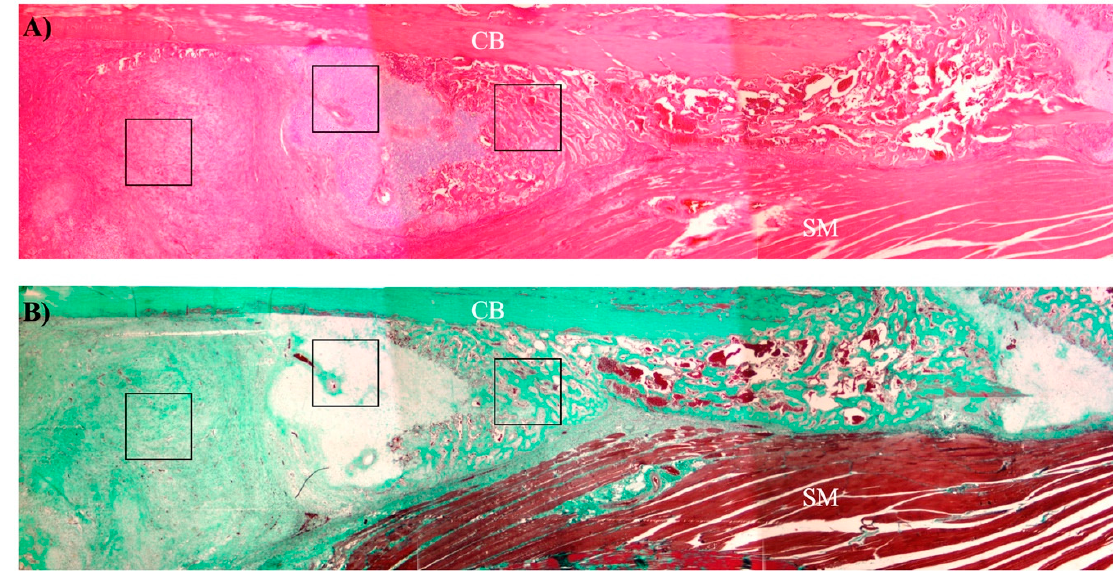
Figure 12. Representative low magnification image of a bone callus showing the approximate areas of each tissue com- partment. ( A ) Hematoxylin-eosin staining. ( B ) Masson’s trichrome staining. CB: cortical bone; SM: skeletal muscle; black squares: different tissue compartments of bone callus (from left to right: connective tissue, cartilage, and new bone tissue).